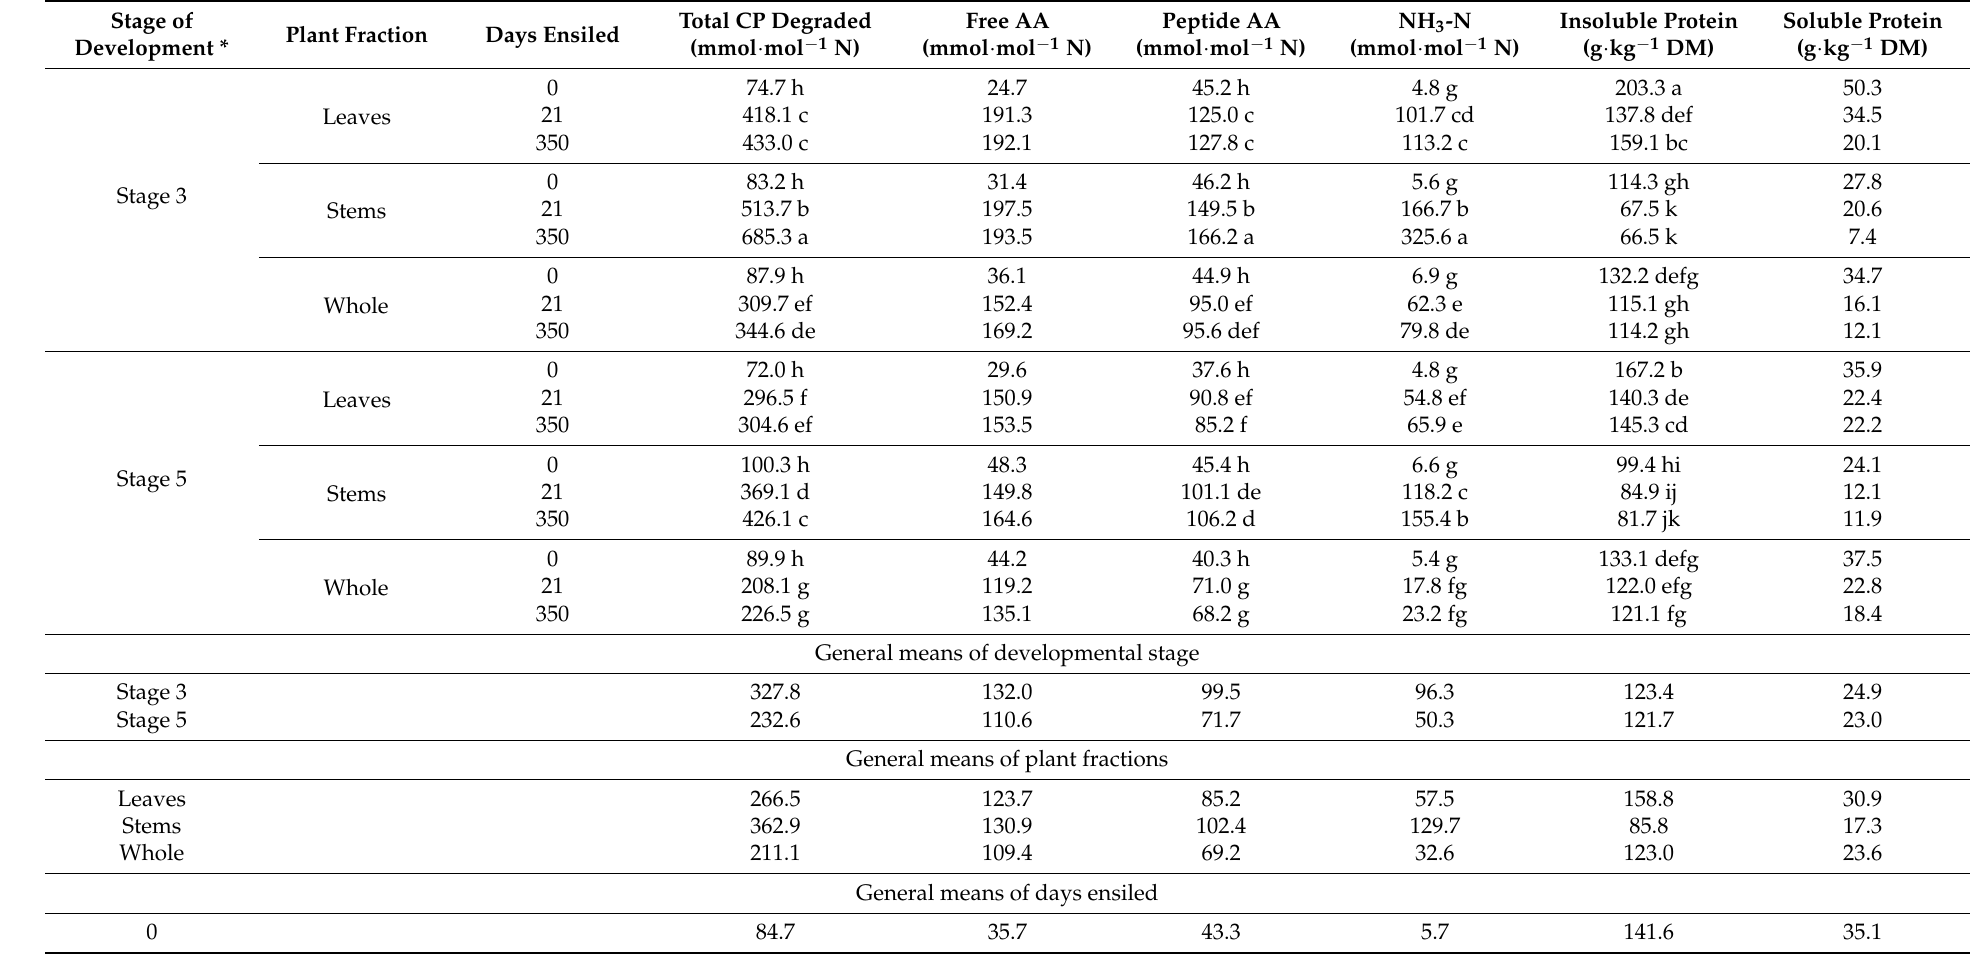
Table 3. Protein degradation to amino acids, peptides, and ammonia, and true protein (insoluble and soluble protein) of alfalfa leaf, stem, and wilted whole-plant silages at two developmental stages before and after